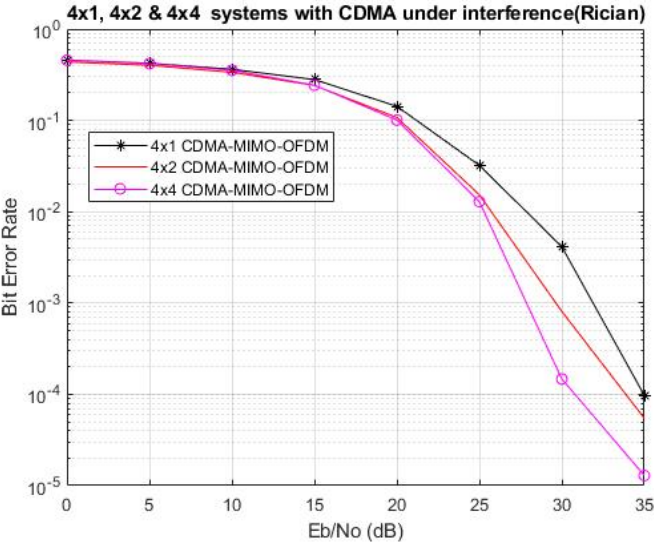
Figure 14. SNR vs. BER plot in Rician channel for CDMA-MIMO-OFDM model. Table 1. BER Values corresponding to 5dB, 15dB, 25dB and 35 dB. SNR in Rayleigh